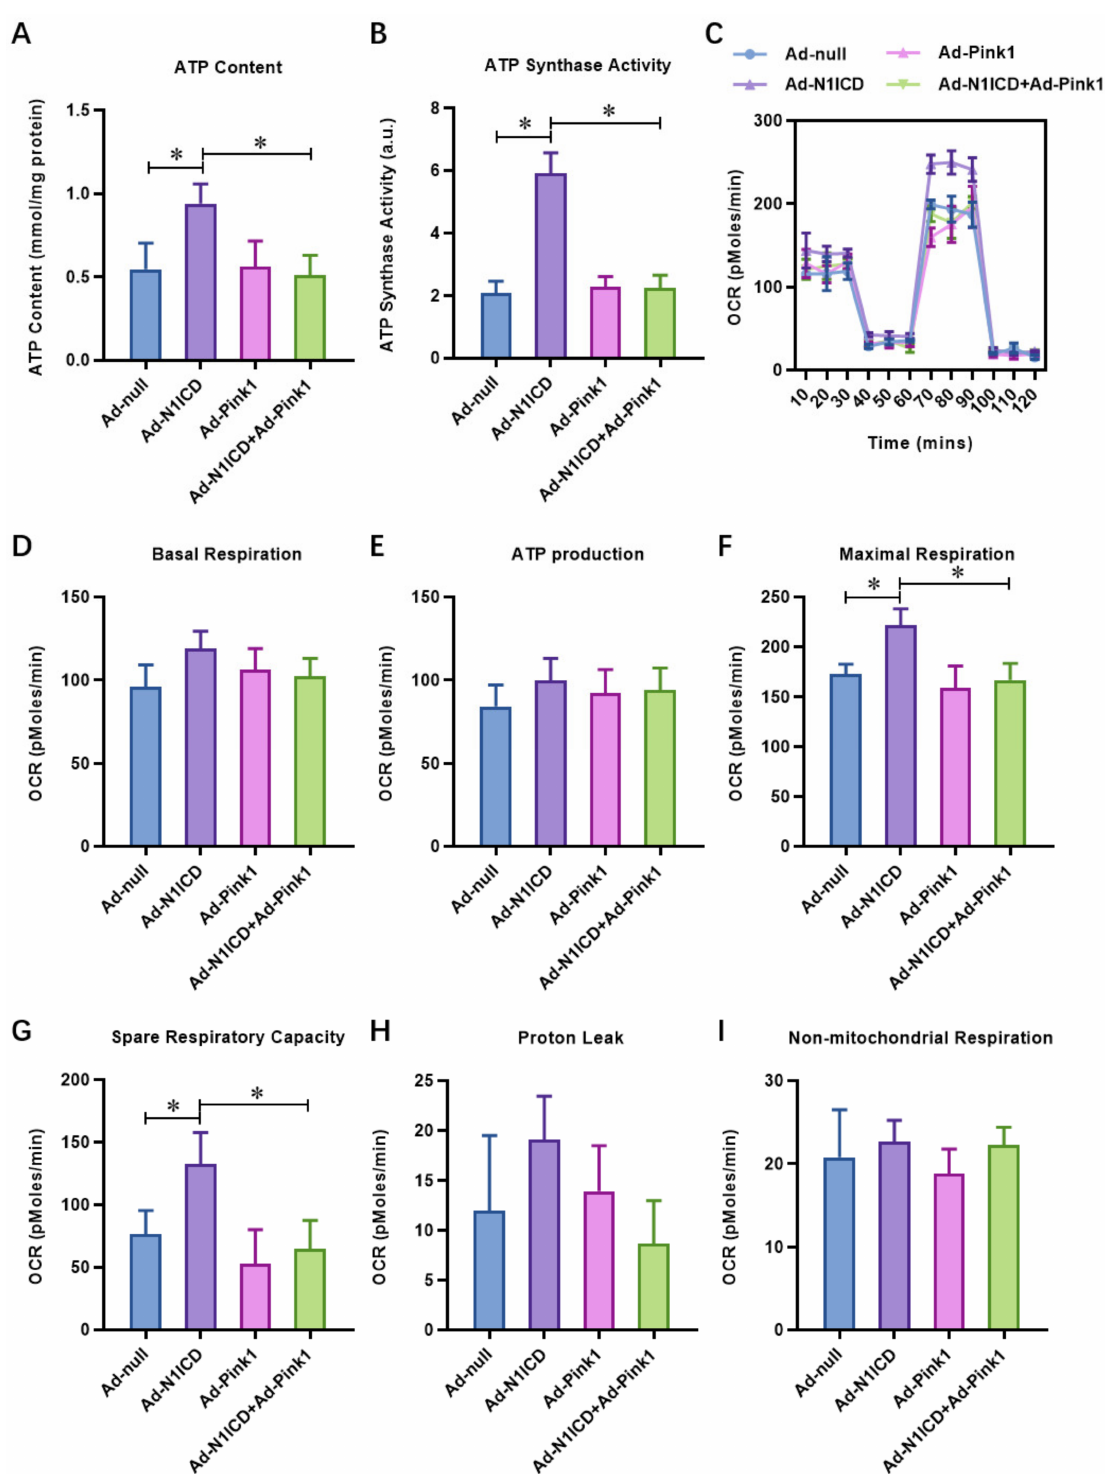
Figure 6. Pink1 over-expression impaired the protective effect of N1ICD against hy- poxia/reoxygenation induced mitochondrial dysfunction in neonatal cardiomyocytes. ( A ) The ATP content and ( B ) ATP synthase activity was analyzed by quantitative kits; ( C ) the mitochondrial bioenergetics were measured by the seahorse XFp Extracellular Flux Analyzer. The ( D ) basal respi- ration (BR), ( E ) ATP production, ( F ) maximal respiration (MR), and ( G ) spare respiratory capacity (SPR), ( H ) proton leak, and ( I ) non-mitochondrial respiration were analyzed; N = 3; * p < 0.05 versus indicated